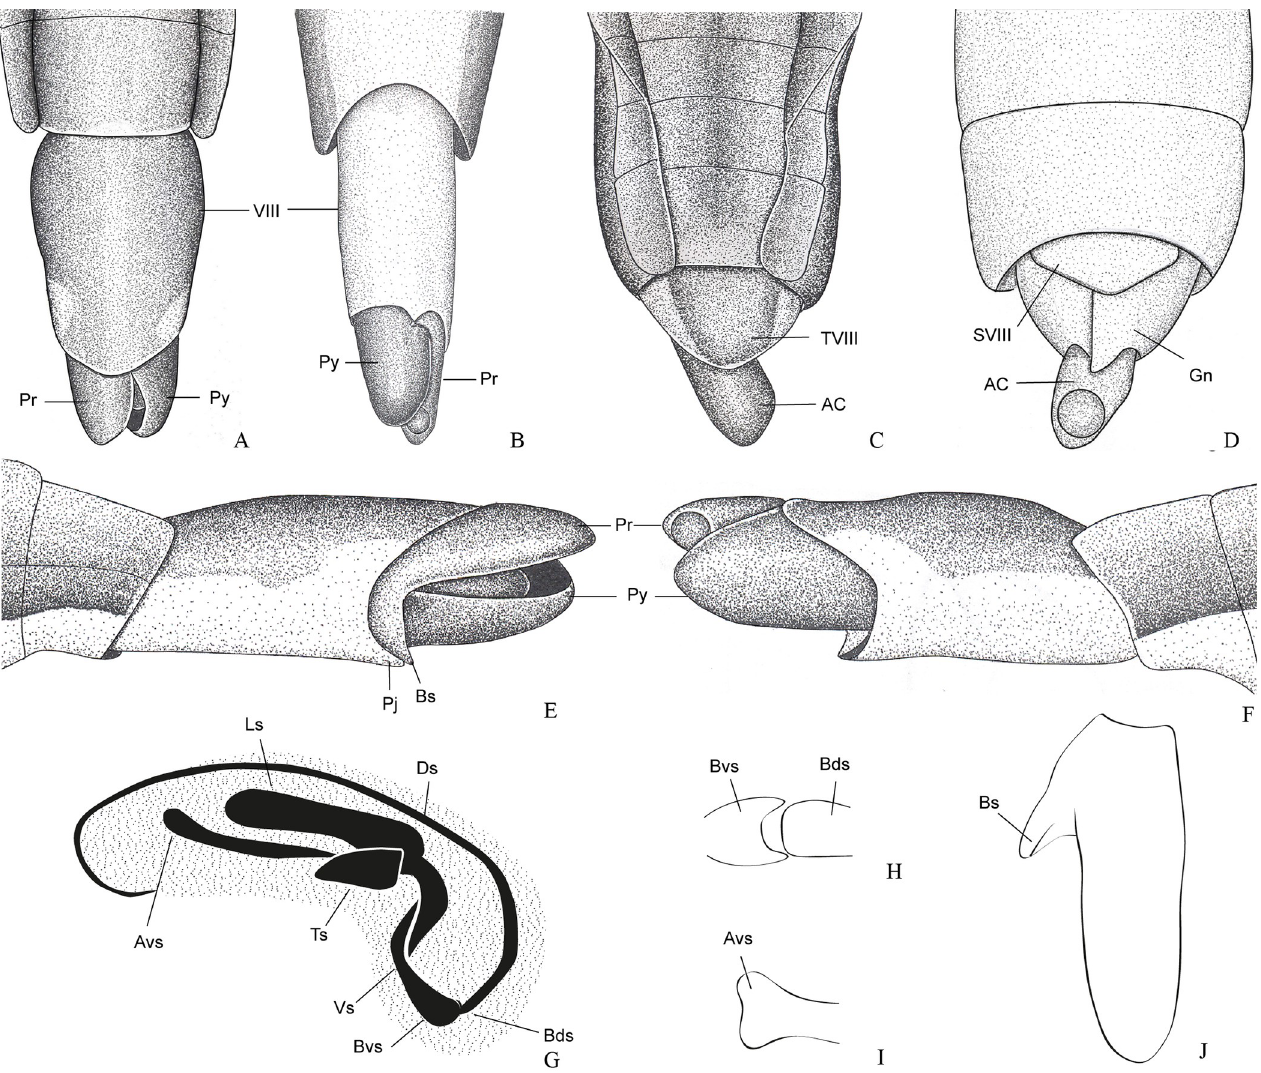
Fig 7. Potamobates horvathi . (A) Male, terminalia, dorsal view; (B) male, terminalia, ventral view; (C) female, terminalia, dorsal view; (D) female, terminalia, ventral view (E) male, terminalia, left lateral view; (F) male, terminalia, right lateral view; (G) phallus, lateral view; (H) junction between dorsal and ventral sclerite; (I) base of ventral sclarite; (J) proctiger, dorsal view.